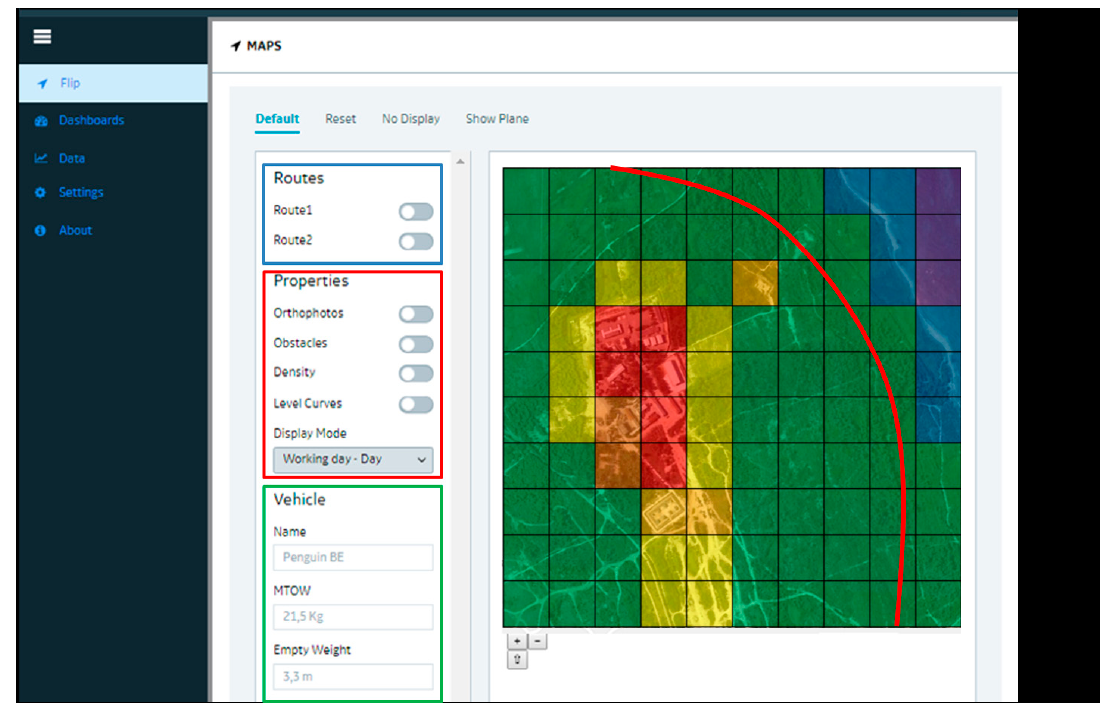
Figure 4. Combination of di ff erent visualization layers in the FLIP